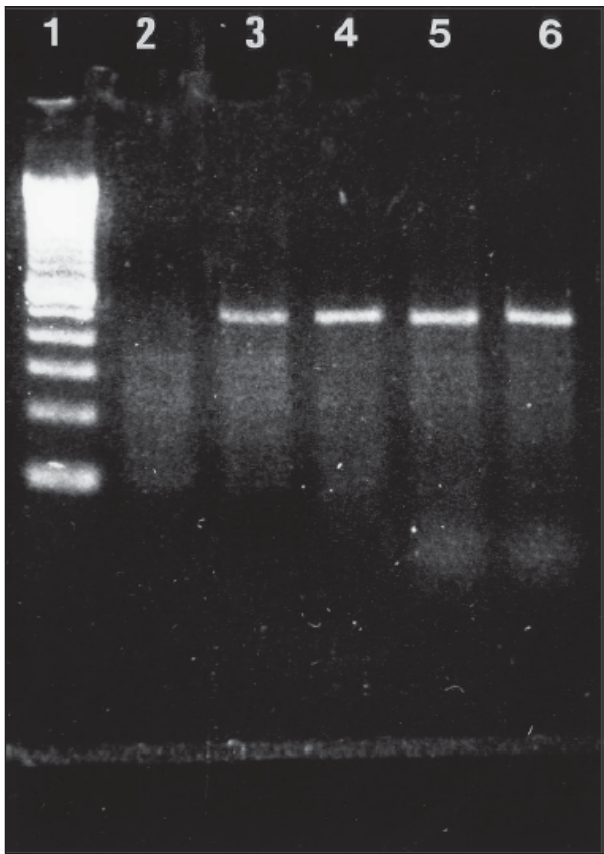
Figure 4) Restriction enzyme analysis following digestion of